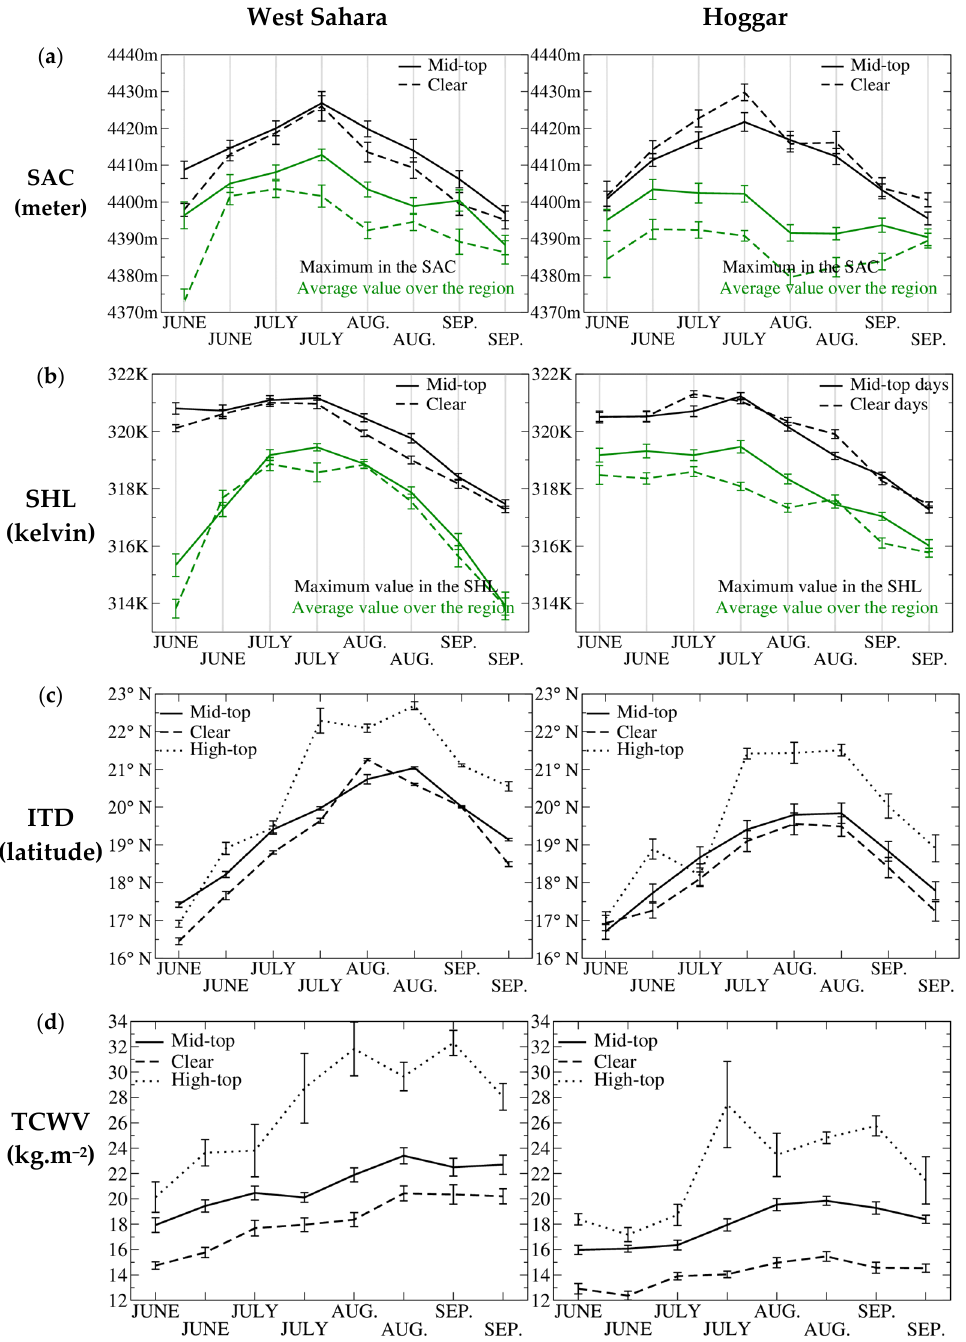
Figure 11. ( a ) Z600 (green) and average value of the SAC inside the region of maximum value (black) for mid-top days (solid line) and clear days (dashed line). ( b ) T850 (green) and average value of the SHL inside the region of maximum value (black) for mid-top days (solid line) and clear days (dashed line). ( c ) The ITD average latitude, for mid-top days (solid line), clear days (dashed line) and high-top days (dashed-dotted line). ( d ) Total column water vapor (TCWV) for mid-top days (solid line), clear days (dashed line) and high-top days (dashed-dotted line). Statistical uncertainty of the mean values (vertical bars). Data estimated over 15 day periods. Information is given for West-Sahara (left column) and Hoggar (right column).